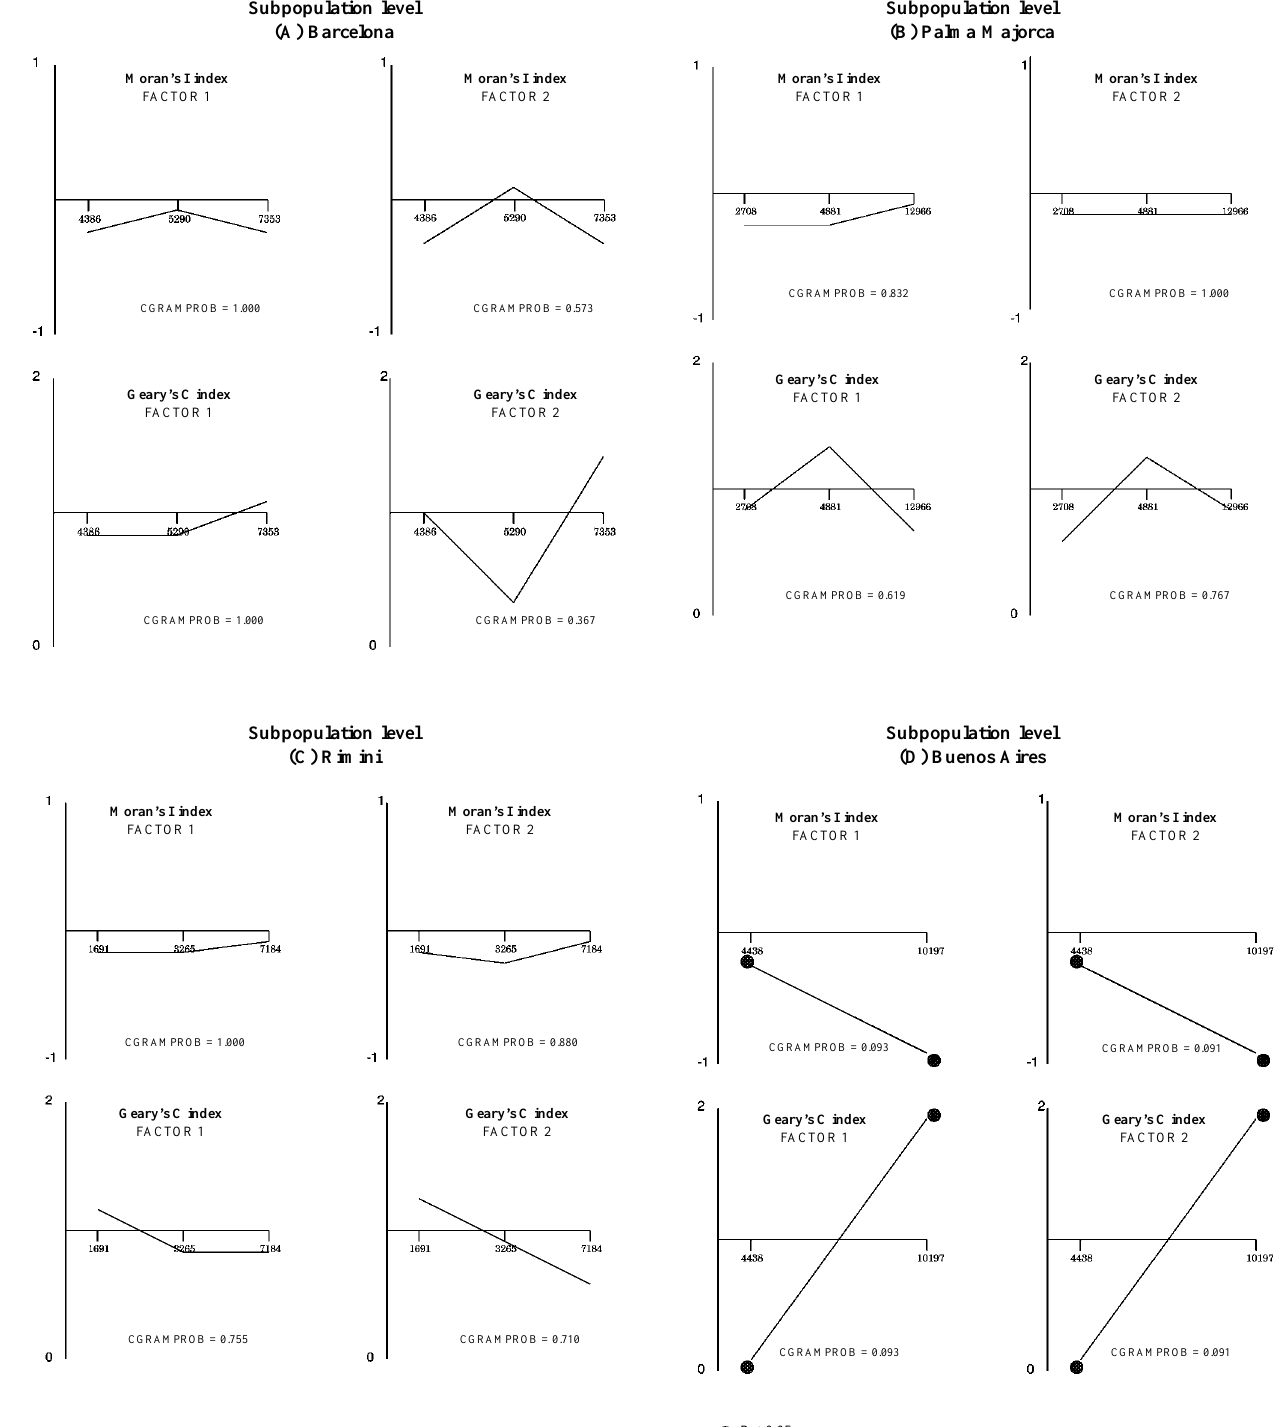
Figure 2 - Correlograms of the correlation between individual subpopulations of the four cities analyzed and the two first factors (1 and 2) obtained from a Q factorial analysis. The correlograms were obtained with Moran´s and Geary´s indexes with 3 distance classes (DC) at subpopulation level. (A) Barcelona; (B) Palma majorca; (C) Rimini; (D) Buenos Aires. CGRAMPROB = Overall correlogram